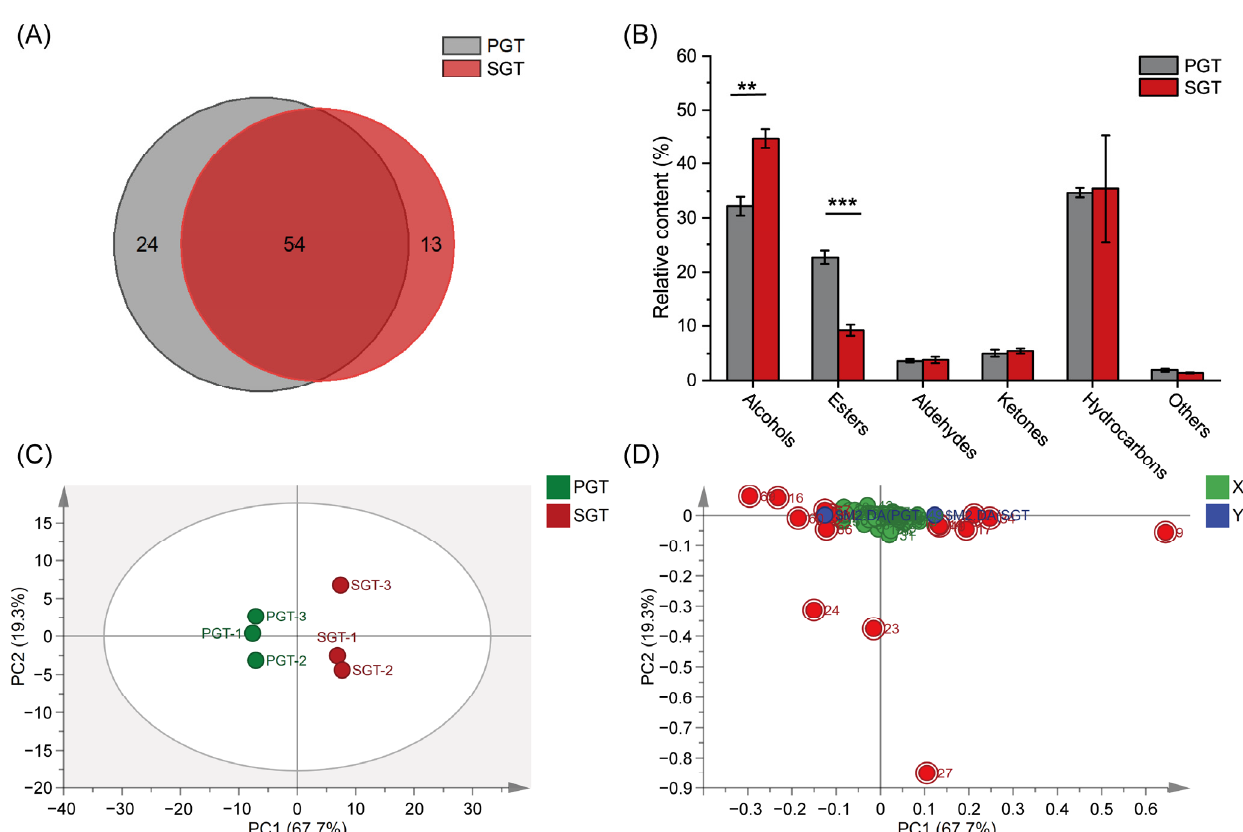
Figure 2. Effect of fixation methods on volatile compounds of green tea. ( A ) Venn diagram of volatile compounds; ( B ) Relative contents of volatile compounds in different classes; ( C ) Score scatter plot of OPLS-DA analysis; ( D ) Loading scatter plot of OPLS-DA analysis. PGT, pan-fired green tea; SGT, steamed green tea; OPLS-DA, orthogonal partial least squares discriminant analysis. ** p < 0.01; *** p < 0.001.